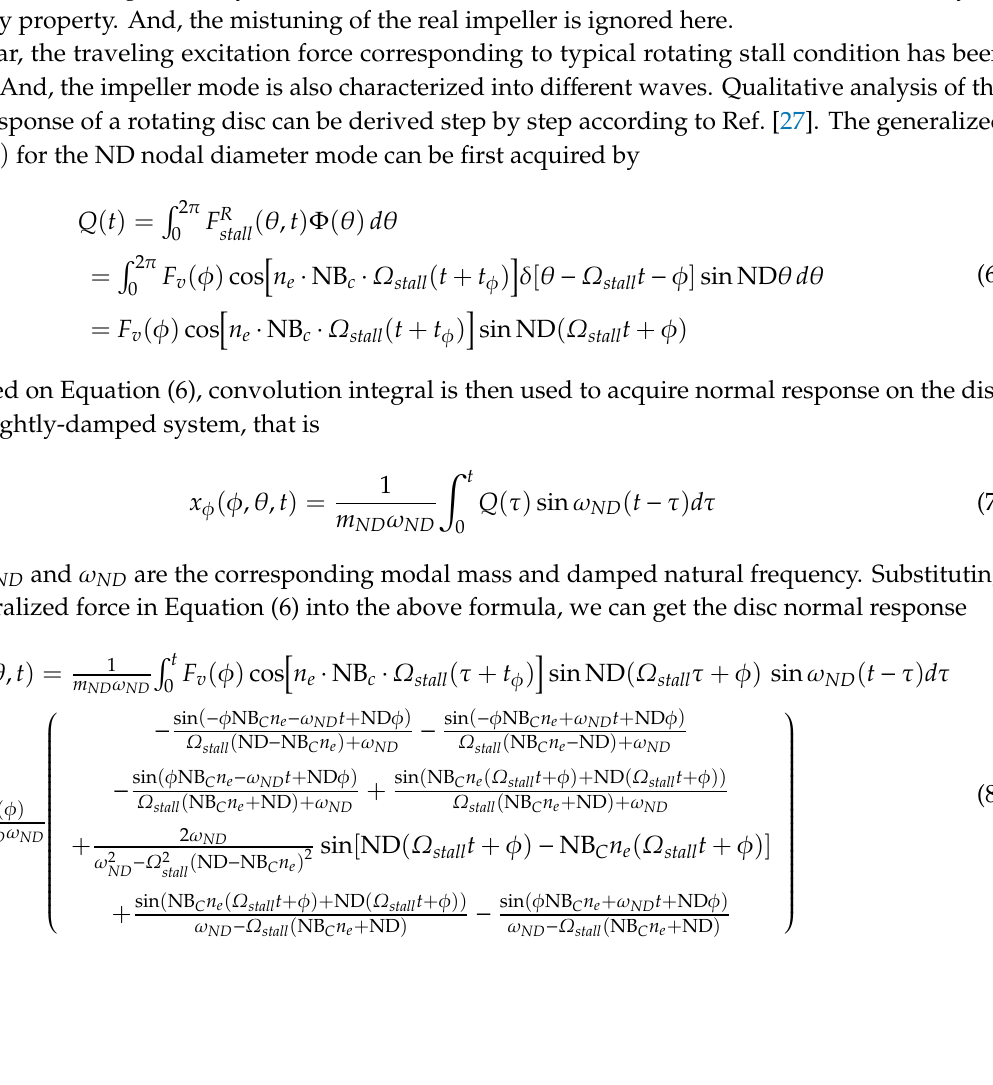
Figure 2. Rotating stall induced impeller forced vibration model based on simplified disc vibration behavior at the time t = 0 ( a ) and t = t 1 ( b ) in